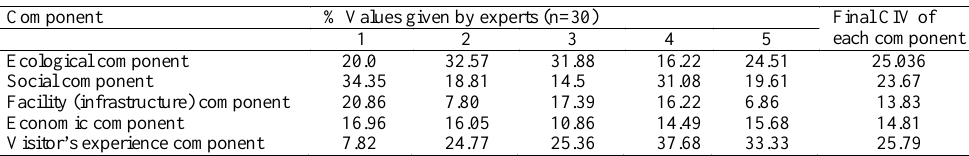
Table 3: Component Importance Value of Kerwa destination as given by experts for each component Component